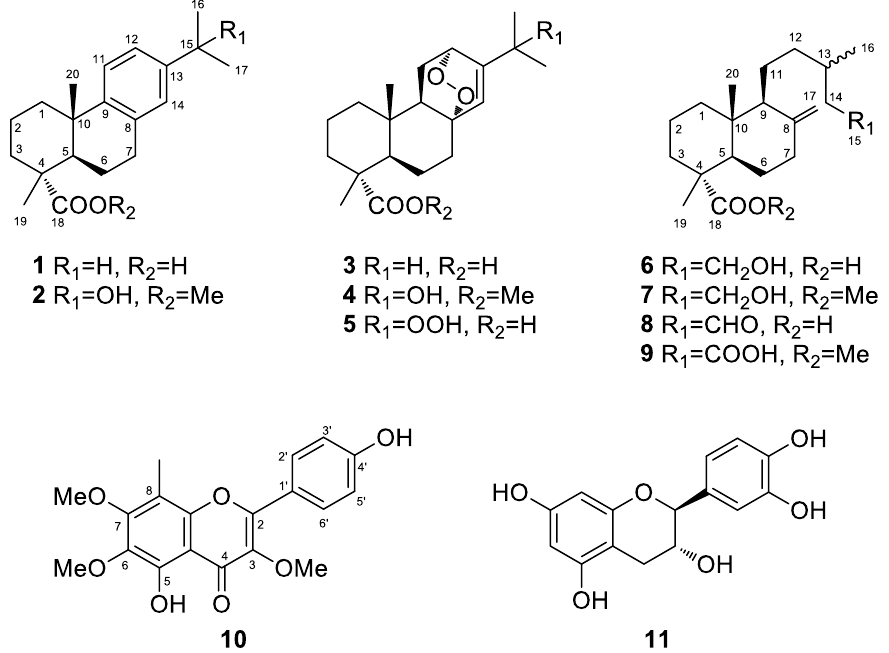
Figure 2. Structures of compounds 1 – 11 isolated from the organic extract of the fresh needles of P. nigra subsp. nigra .